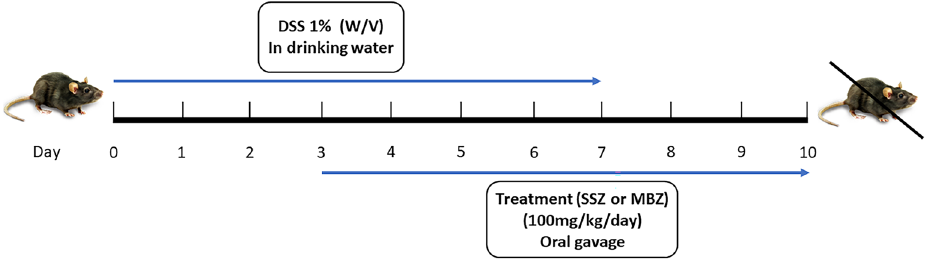
Figure 1. Schematic presentation of the study